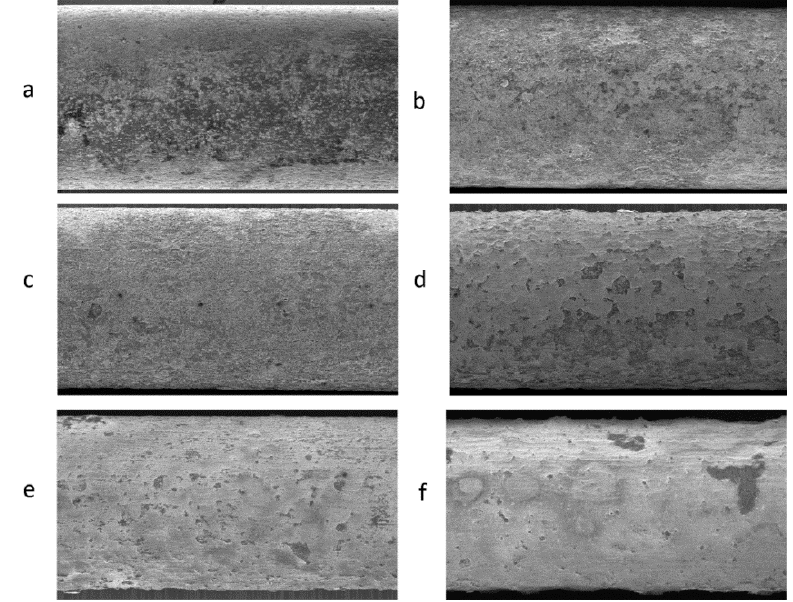
Figure 5. Typical morphology of wire specimens after immersion times of ( a ) 0 day; ( b ) 3 days; ( c ) 6 days; ( d ) 10 days; ( e ) 20 days; and ( f ) 30 d. (SEM Magnification: 400×).